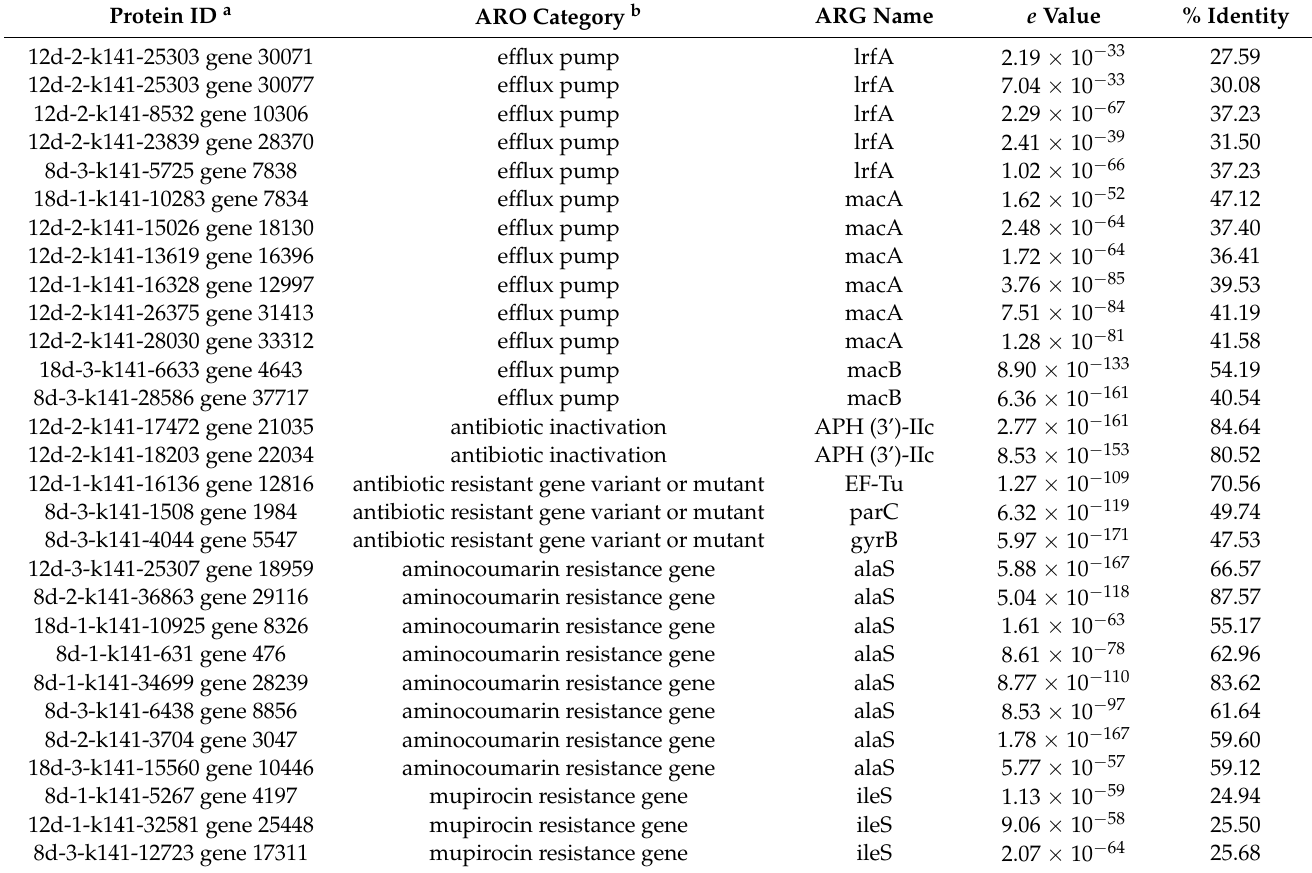
Table 4. List of antibiotic resistance genes retrieved from vinegar Pei virome contigs. Protein ID